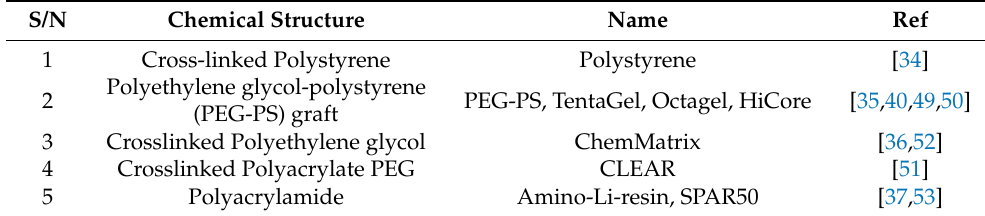
Table 1. Common resins used in SPPS and their chemical